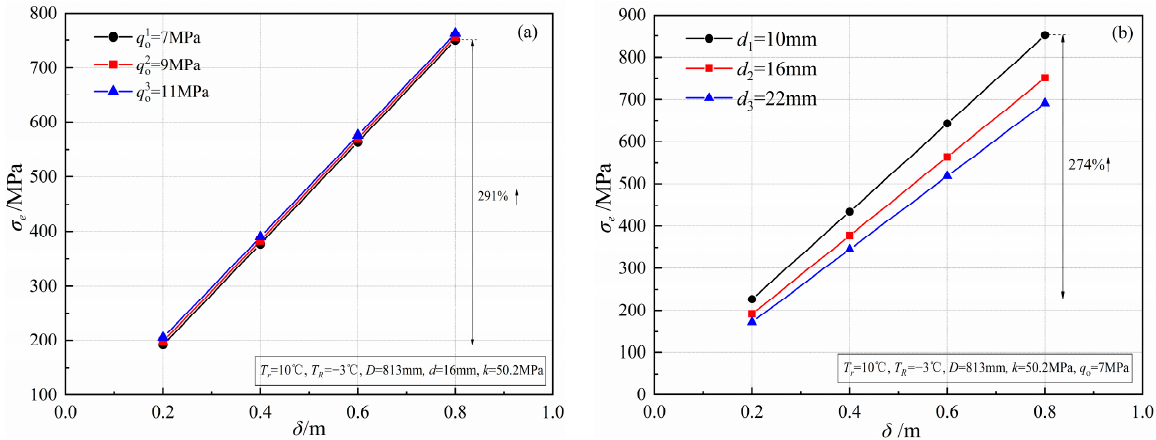
Figure 6. Variations of equivalent stresses with frost heave. ( a ) Under different oil pressures; ( b ) Under different wall thicknesses.